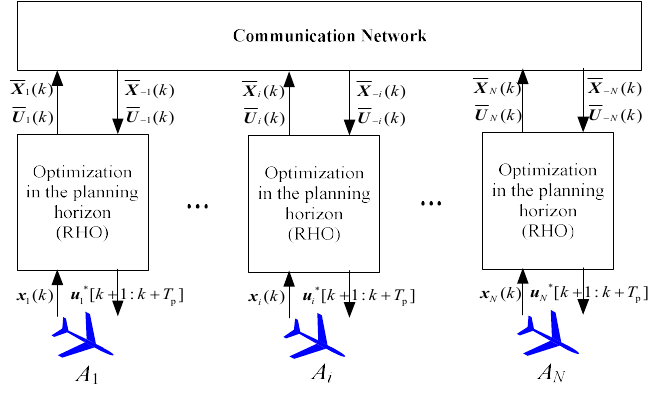
Figure 3. Sketch of the distributed decision-making model for multiple UAV cooperative target tracking.